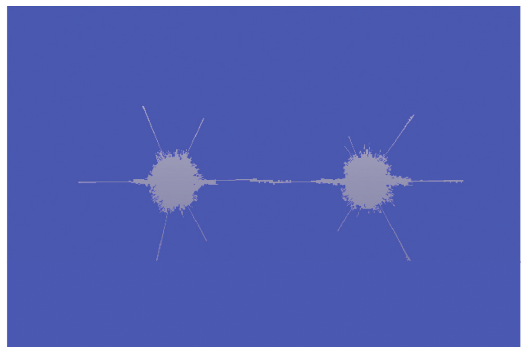
Figure 10: Crack penetration of shaped charge